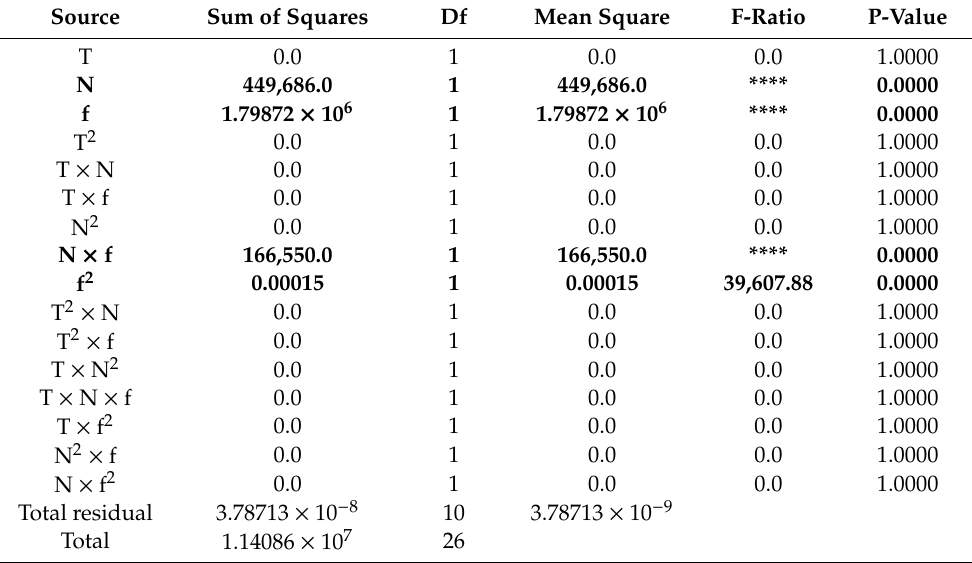
Table 5. Analysis of variance for material removed rate ( MRR)